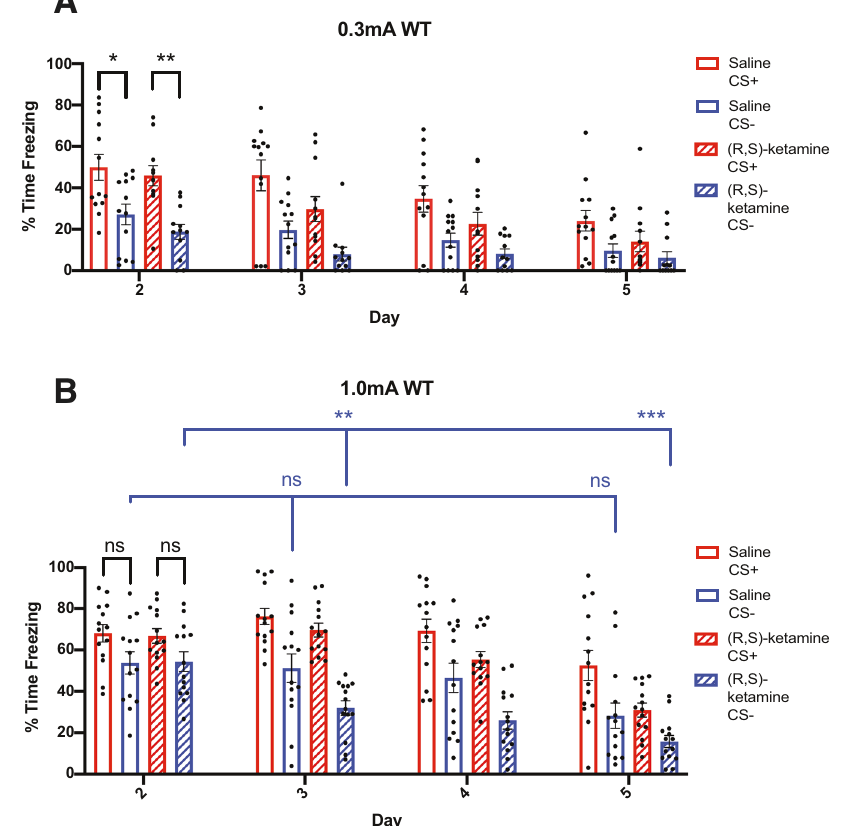
Fig. 2 Auditory fear conditioning with a strong foot shock induces fear generalization behavior in wild type (WT) mice, which is reduced by prophylactic administration of (R,S)-ketamine. A , B Percent time freezing to CS + and CS − tones following auditory fear conditioning with either weak (0.3 mA) or strong (1.0 mA) electric foot shocks. A Saline-injected WT mice ( N = 13) and prophylactic (R,S)-ketamine-injected WT mice ( N = 12) conditioned with weak shocks displayed signi fi cantly greater freezing behavior to CS + tones compared to CS − tones on Day 2. B Saline-injected WT mice conditioned with strong shocks ( N = 14) displayed similar levels of freezing behavior to both the CS + and CS − tones during the Day 2 fear recall and did not show signi fi cant reductions in Day 2 v. Day 3 or Day 2 v. Day 5 freezing for the CS − tone. testing. Error bars represent mean ± SEM. Three-way RM ANOVA with post hoc Tukey HSD tests, *** p < 0.001, ** p < 0.01, * p < 0.05, ns = p >